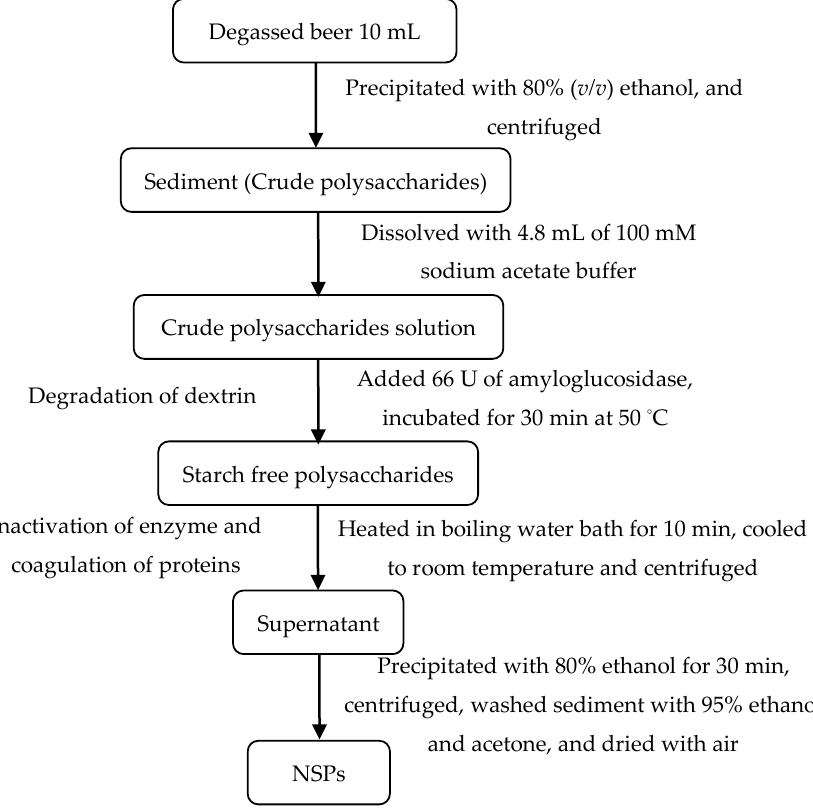
Figure 1. Purification procedure of non-starch polysaccharides (NSPs) in commercial beers.